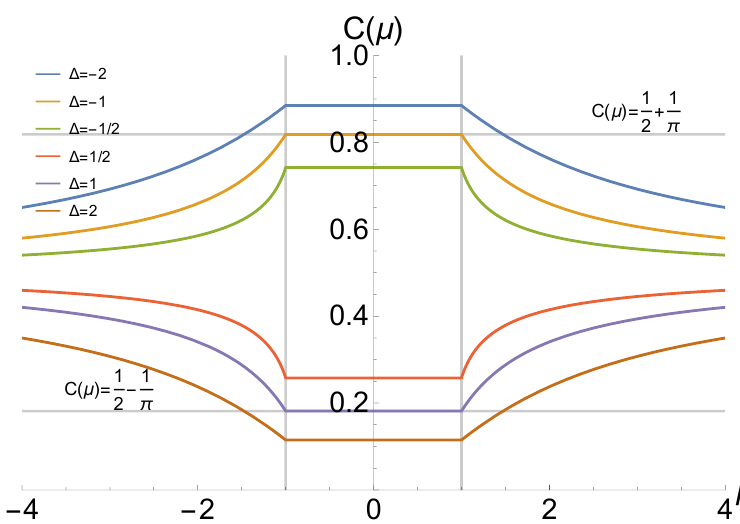
Figure 4 . Complexity C ( s = 1; µ, ∆) as a function of µ for various choices of ∆ ( ∆ = − 2 , − 1 , − 1 / 2 , 1 / 2 , 1 , 2 ) for the circuit connecting the Cooper-pair ground state and Kitaev chain ground state. Between the two vertical gridlines µ = ± 1 , spread complexity is µ -independent. The two dashed horizontal gridlines are the analytical results of C ( | µ | < 1 , ∆ = ± 1) , respectively. For | µ | → ∞ , the spread complexities of various ∆ s approach the dotted horizontal gridline C = 1 / 2 .